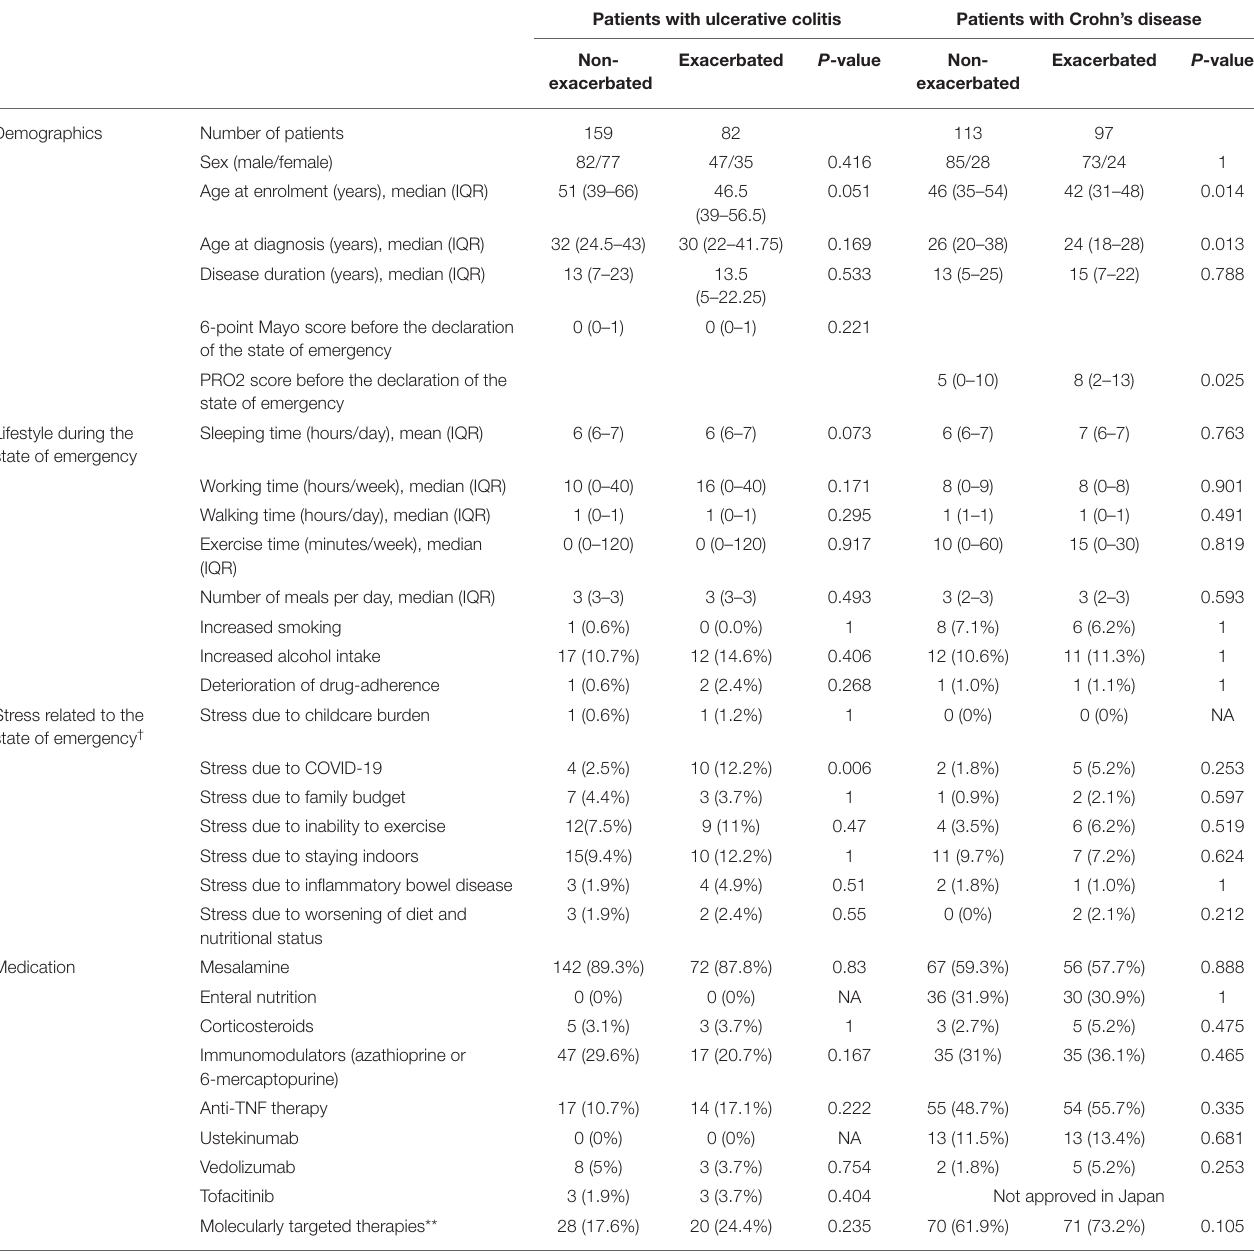
TABLE 2 | Descriptive comparison of participants with and without exacerbation.